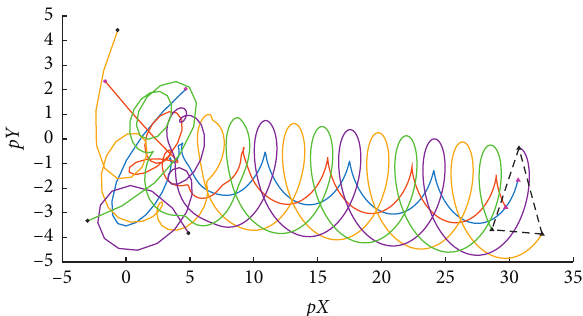
Figure 3: The trajectory of agents’ positions over time with time delay.